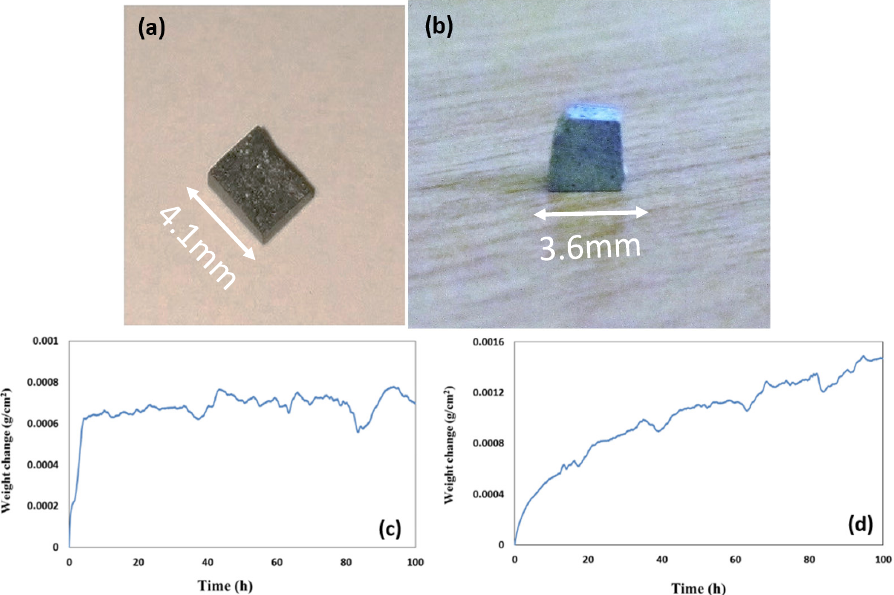
Figure 12. Oxidised specimens of the alloy Nb 1.3 Si 2.4 Ti 2.4 Al 3.5 Hf 0.4 ( a ) at 800 °C and ( b ) at 1200 °C and weight change versus time ( c ) at 800 °C and ( d ) at 1200 °C.